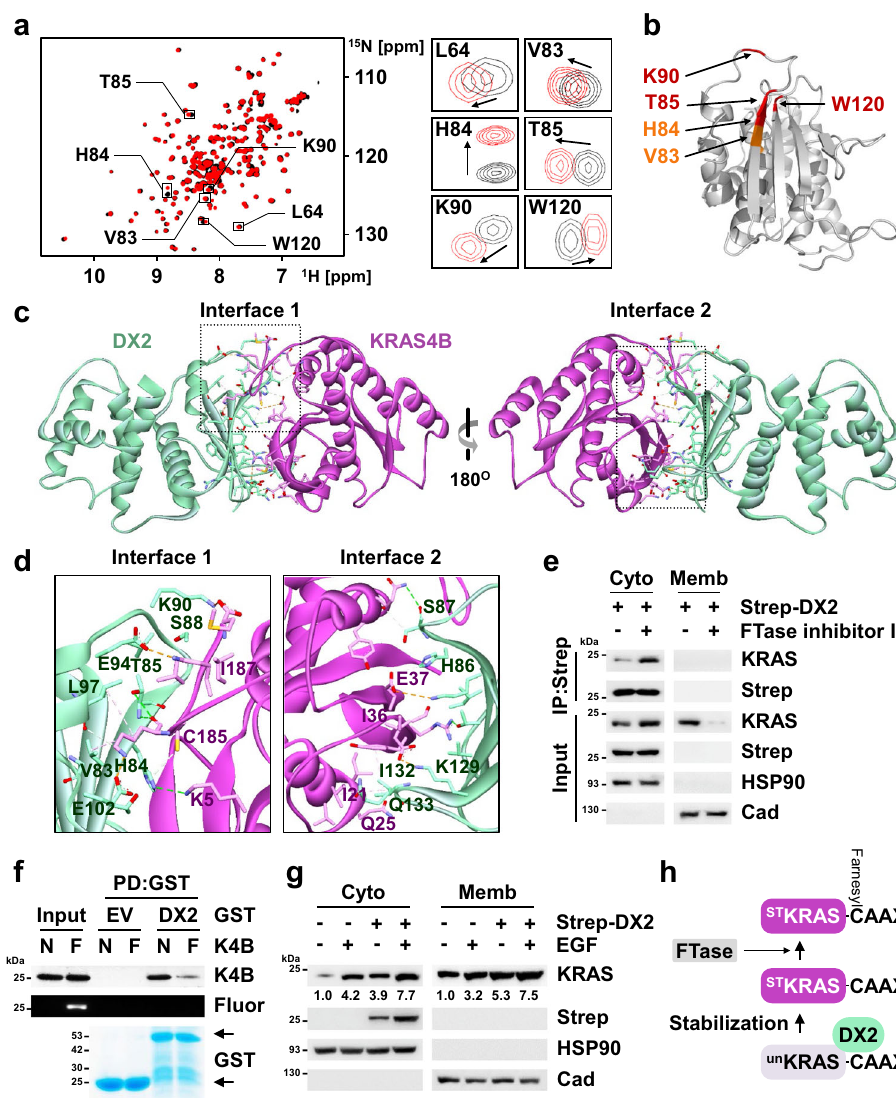
Fig. 3 Analysis of the binding mode of action between KRAS and DX2. a , b Chemical shift perturbation of 15 N-labeled DX2 51-251 (C136S, C222S) by the binding to KRAS4B HVR peptide. Superposition of the 2-dimensional (2D) 1 H- 15 N TROSY spectra of free DX2 in the presence (red) and absence (black) of HVR peptide. Strongly affected residues are depicted ( a , left) and the indicated signals are enlarged and presented ( a , right). The residues showing strong ( Δδ > 0.02 ppm) and medium (0.01 < CSP ≤ 0.02 ppm) perturbation are shown in red and orange, respectively, on the surface of the DX2 GST domain ( b